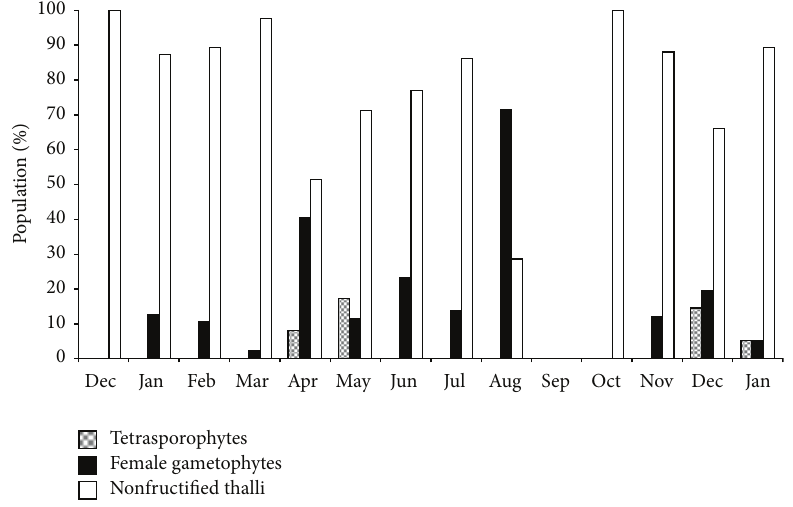
Figure 6: Population structure of Calliblepharis jubata in Buarcos